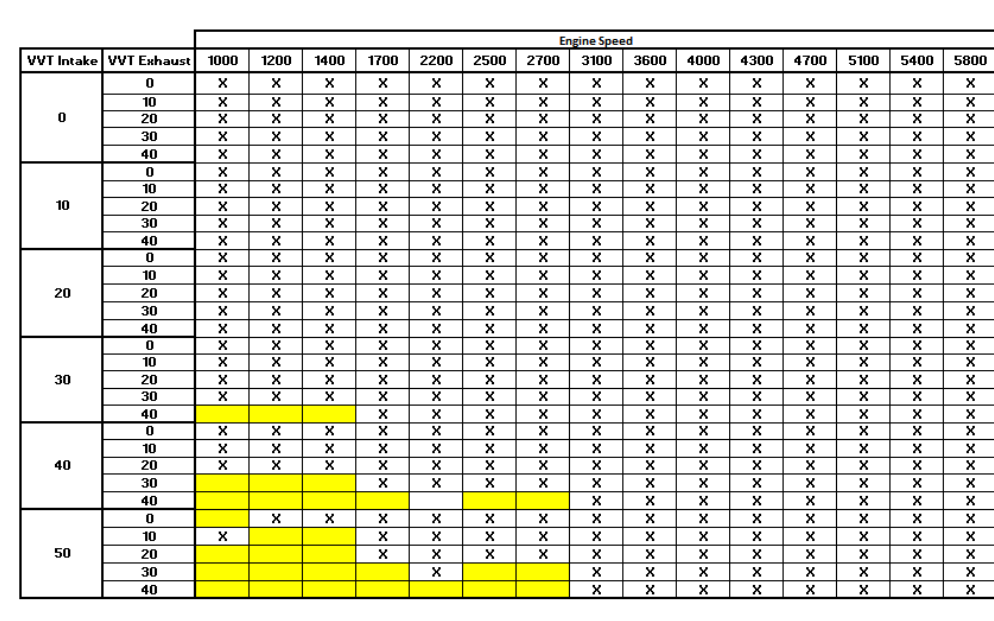
Figure A1. Acquisition points.